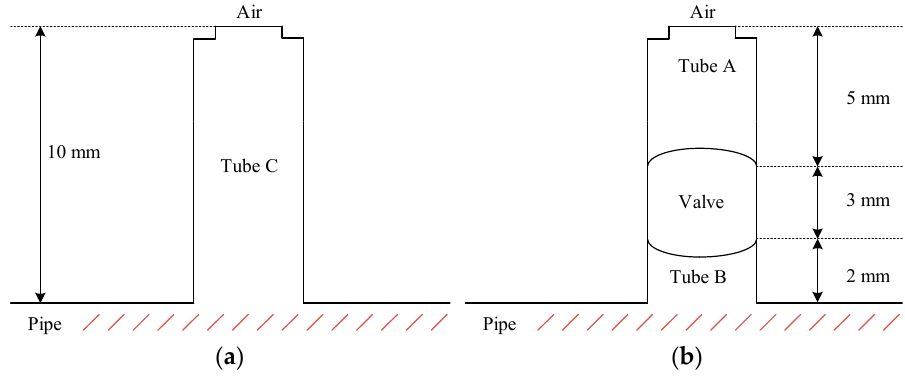
Figure 2. Schematic diagram of the leakage hole: ( a ) leakage hole A; ( b ) leakage hole B.